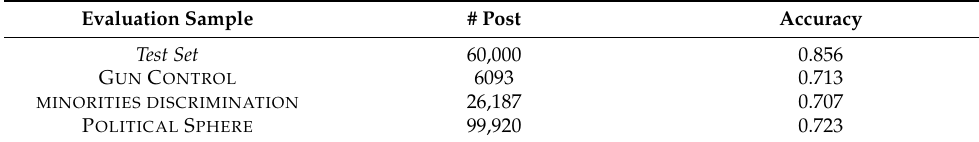
Table 3. BERT performances on evaluation samples.